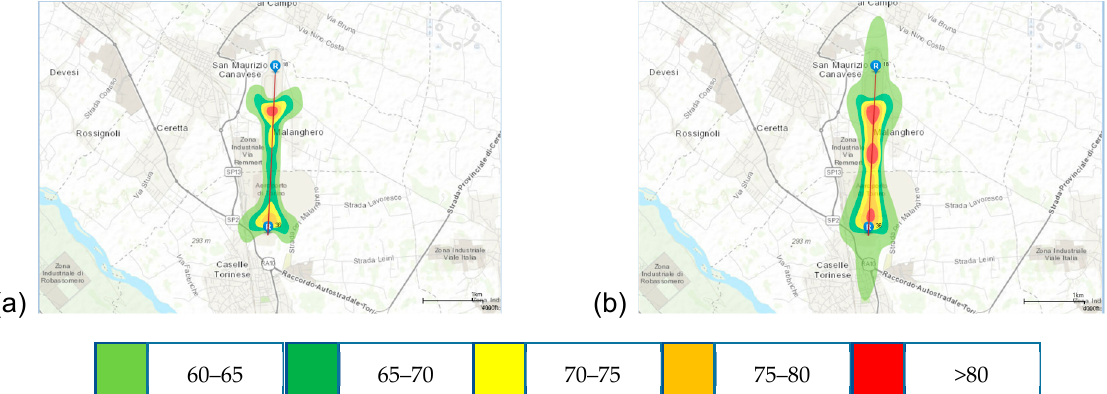
Figure 48. L DEN (dB-A) of the assessed traffic scenario for the conventional ( a ) and hybrid ( b ) configurations.